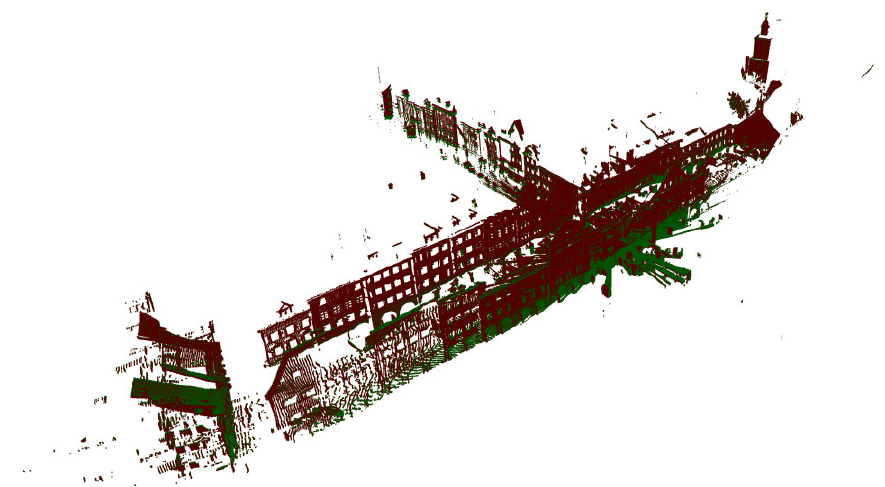
Figure 15. Registration of the whole point cloud. Table 5. Performance comparison in outdoor